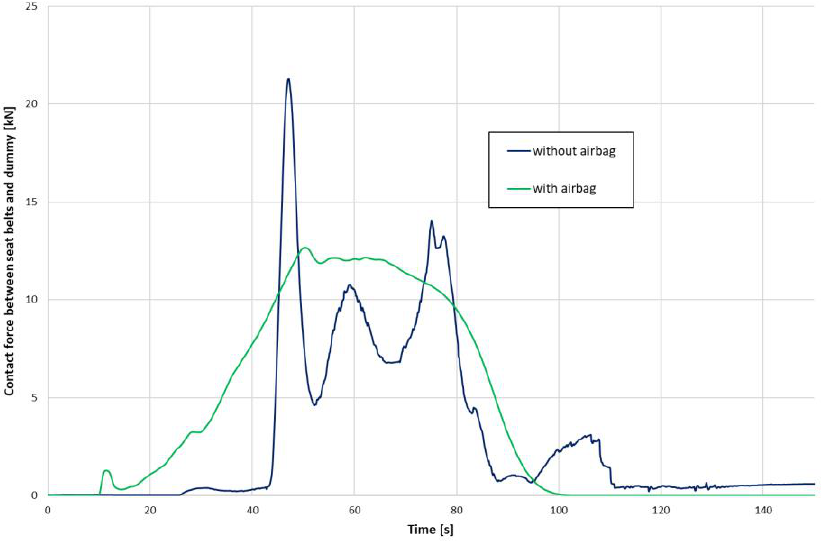
Figure 9. Contact force between seat belts and dummy.